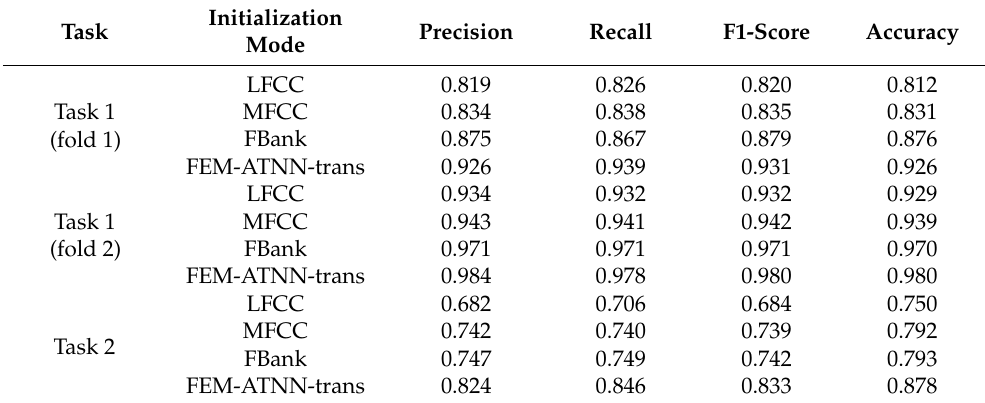
Table 7. Recognition results of proposed method and methods based on mainstream primary